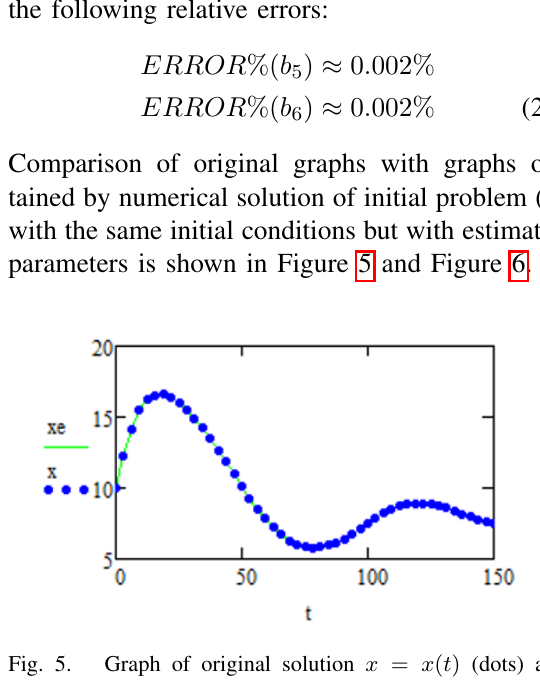
Fig. 5. Graph of original solution x = x ( t ) (dots) and solution with estimated parameters (solid line)